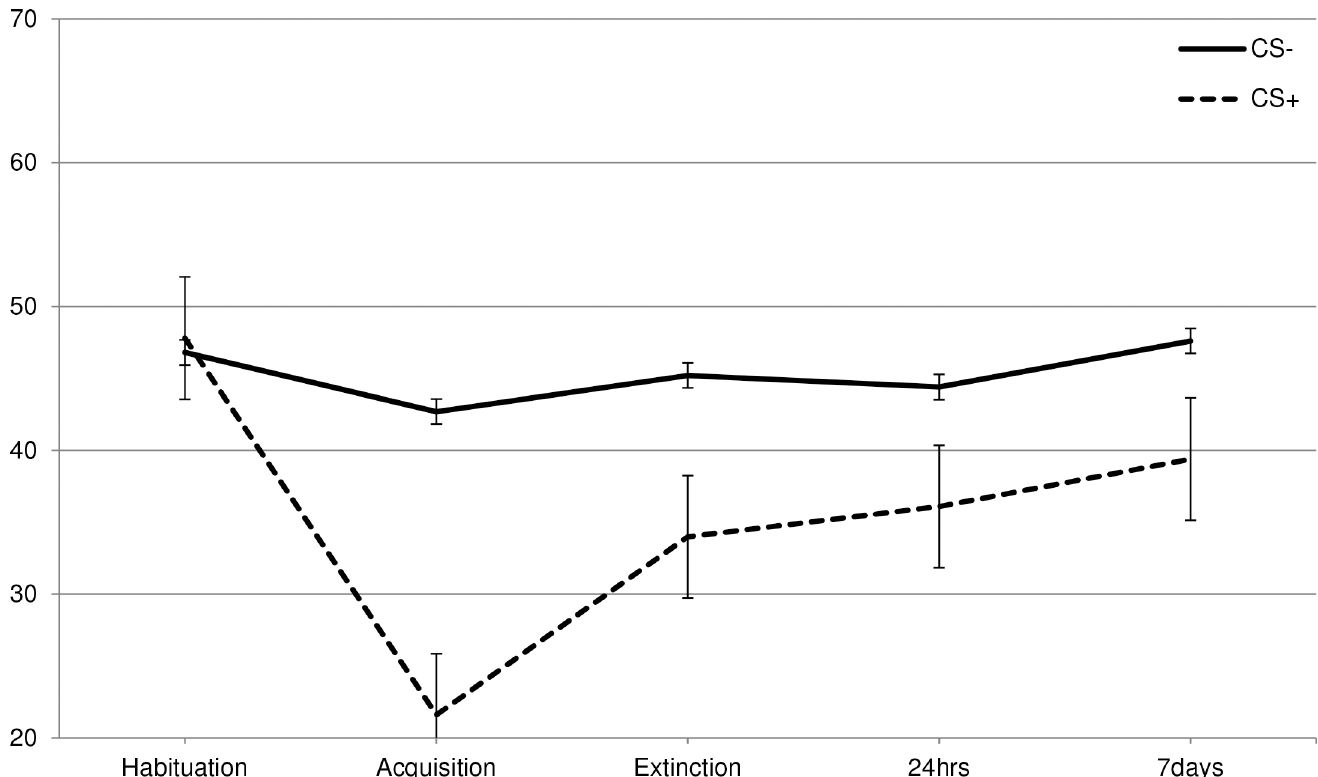
Fig 2. Self-reported willingness-to-eat. Total scores in the different phases (habituation, acquisition, extinction, 24hrs and 7 days) of the self-reported willingness-to-eat.